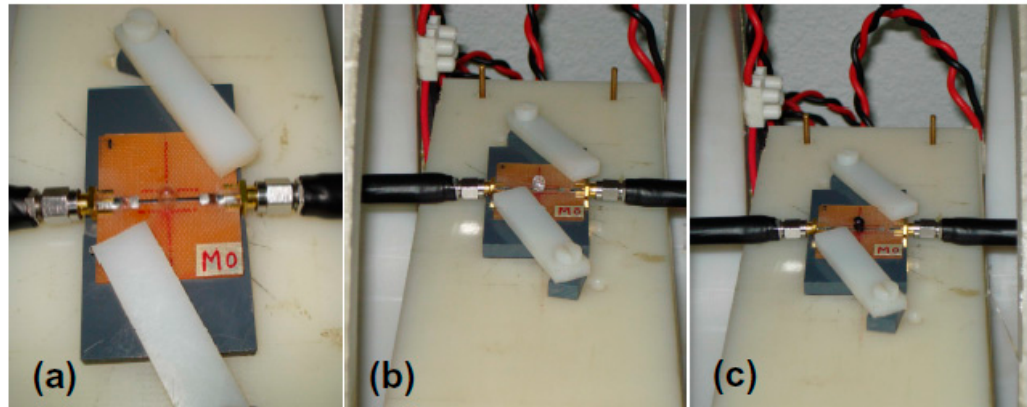
Figure 2. General view of the ribbon based MI sensitive element installed into “microstripe” line; external magnetic field is applied parallel to the long axis of the ribbon: ( a ) polymer capsule is empty (calibration measurement); ( b ) polymer capsule contains xanthan-based G-a gel without MPs; ( c ) polymer capsule contains xanthan-based FG-2a ferrogel with magnetite magnetic particles in 3.19 weight % concentration.